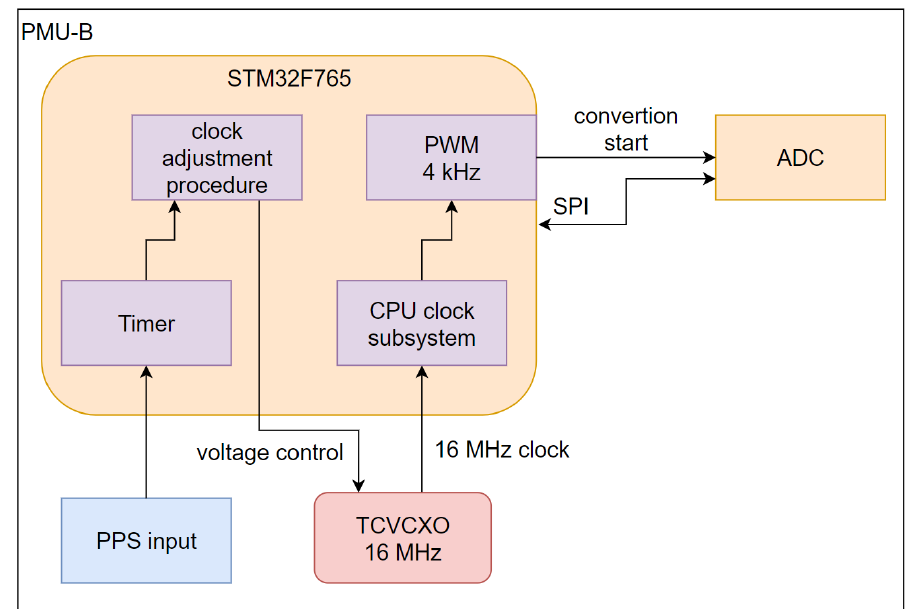
Figure 3. Block scheme of sampling signal generation in